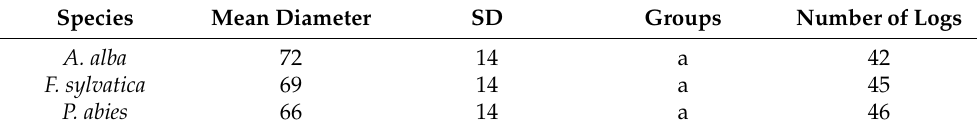
Table 2. Base statistics of sampled downed logs between species. Different letters in Group column indicate significant differences among the species according to mean diameter (one-way